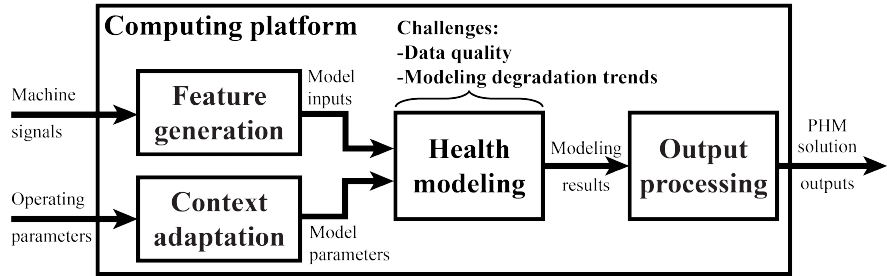
Figure 3. PHM solution architecture with SME